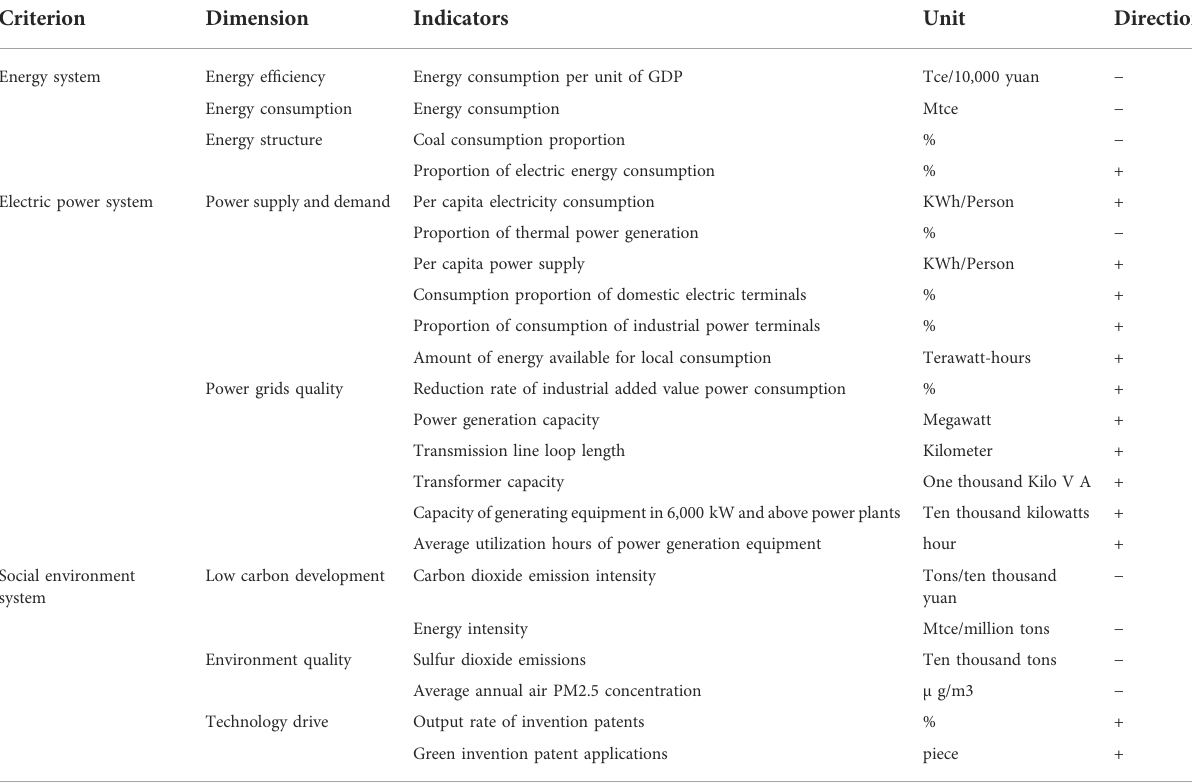
TABLE 1 China ’ s re-electri fi cation